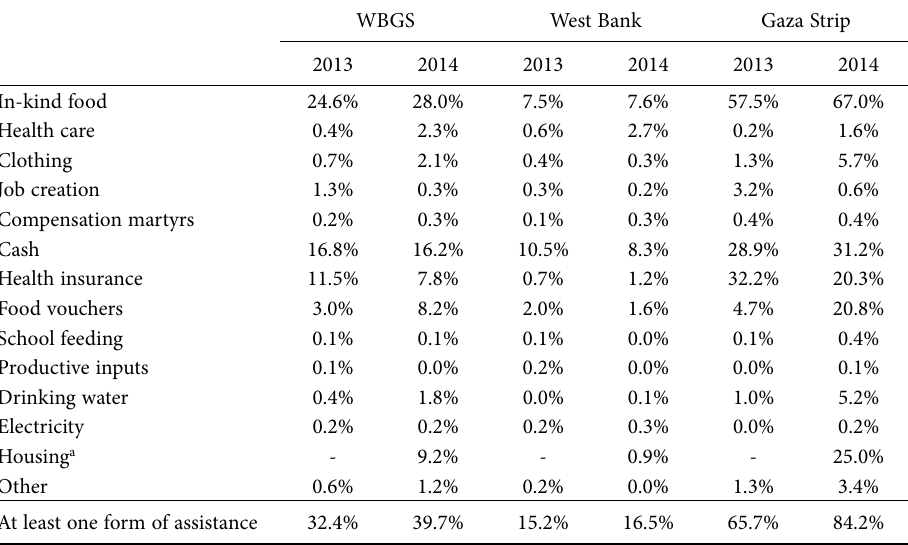
Table 1. Share of households receiving assistance by type of assistance and region,